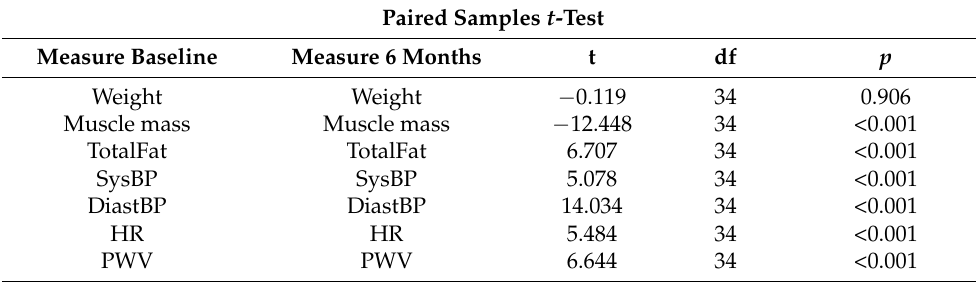
Table 5. Comparative analysis of the arginine group at baseline and six months. Paired Samples t